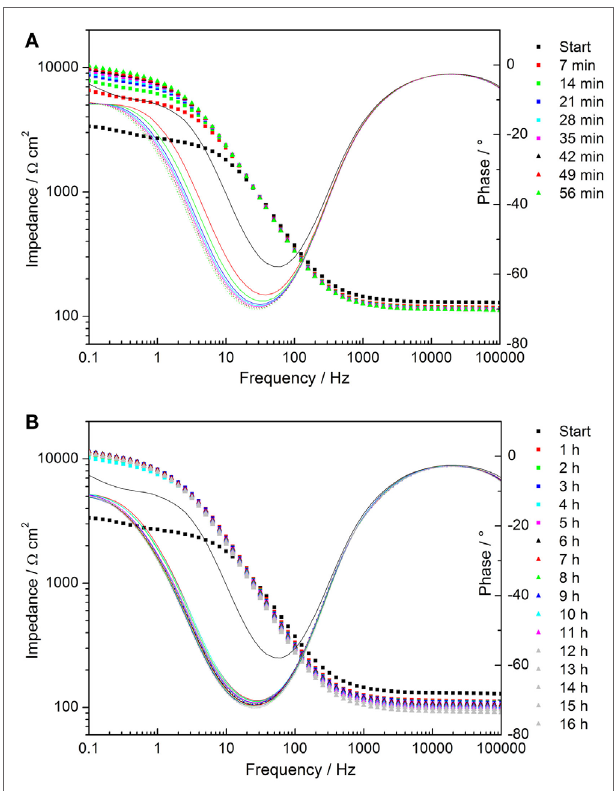
FigUre 8 | (a,B) Time-dependent Bode plots of impedance measurements of AZ31 and cerium oxide-coated sample immersed in 3.5 wt.% NaCl solution; (a) impedance plot and (B) phase